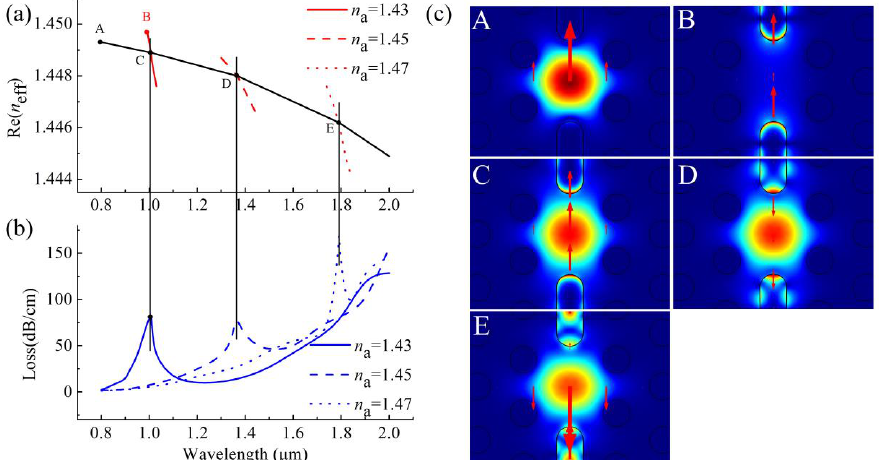
Figure 2. ( a ) Re ( n eff ) curves of the y -polarized core mode (black solid curve) and y -polarized surface plasmon polariton (SPP) mode at n a = 1.43, 1.45, and 1.47 (red solid, red dashed and red dotted curves); ( b ) loss spectra of the y -polarized core mode at n a = 1.43, 1.45, and 1.47; ( c ) y -polarized electric field distributions of core mode and SPP mode at specific wavelengths (A for core mode at 800 nm with n a = 1.43, B for SPP mode at 992 nm with n a = 1.43, C for core mode at 1006 nm with n a = 1.43, D for core mode at 1367 nm with n a = 1.45 and E for core mode at 1791 nm with n a = 1.47), arrows indicate polarized direction of electric fields.